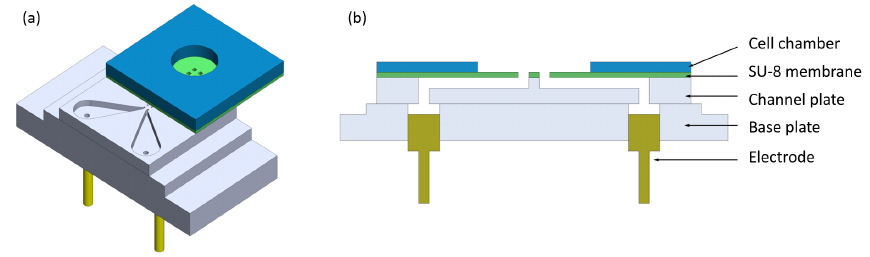
Figure 1. Schematic representation of the microfluidic biochip: (a) device assembly; (b) schematic side view.